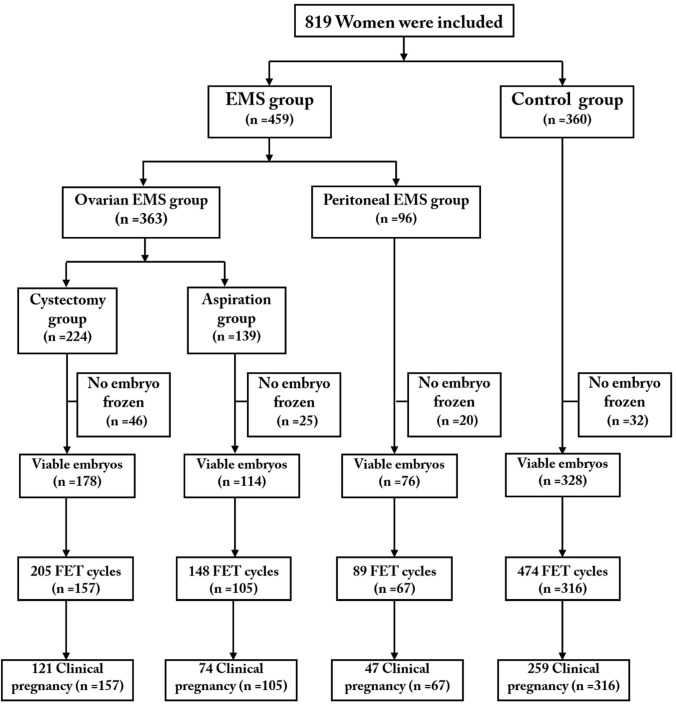
Flowchart for each comparison.